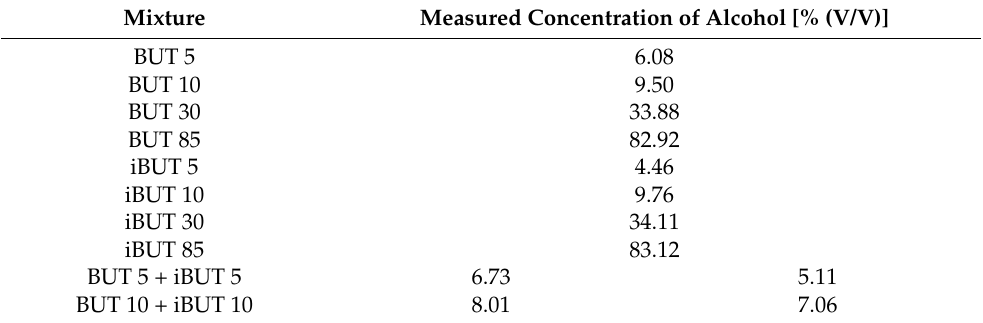
Table 4. Measured concentrations of n-butanol and i–butanol in